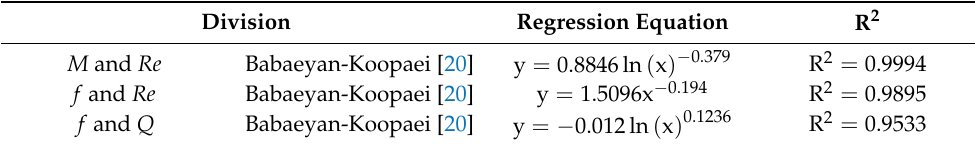
Table 2. The results for the relationship between M , f , Re , and Q using Yuen’s data. Division Regression Equation R 2 M and Re Yuen [19] y = 0.9561ln ( x ) − 4.925 R 2 = 0.8644 Yuen [19]